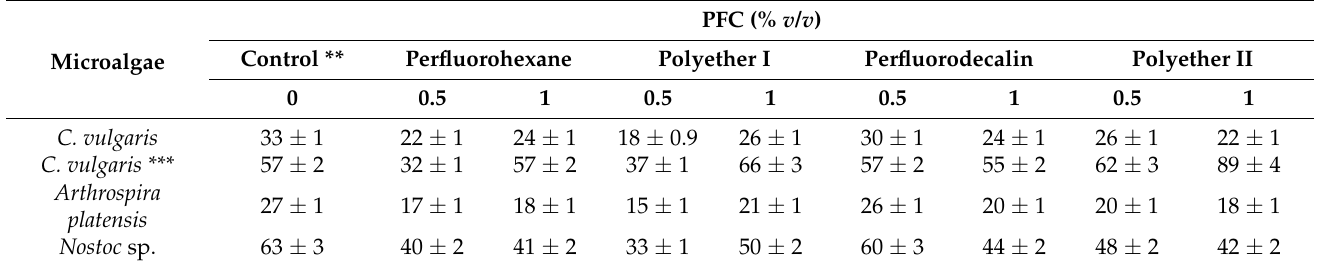
Table 1. Concentration of ATP (nmol/g DCW) * after 3 days of their cultivation in the culture media with various concentrations of different PFCs.